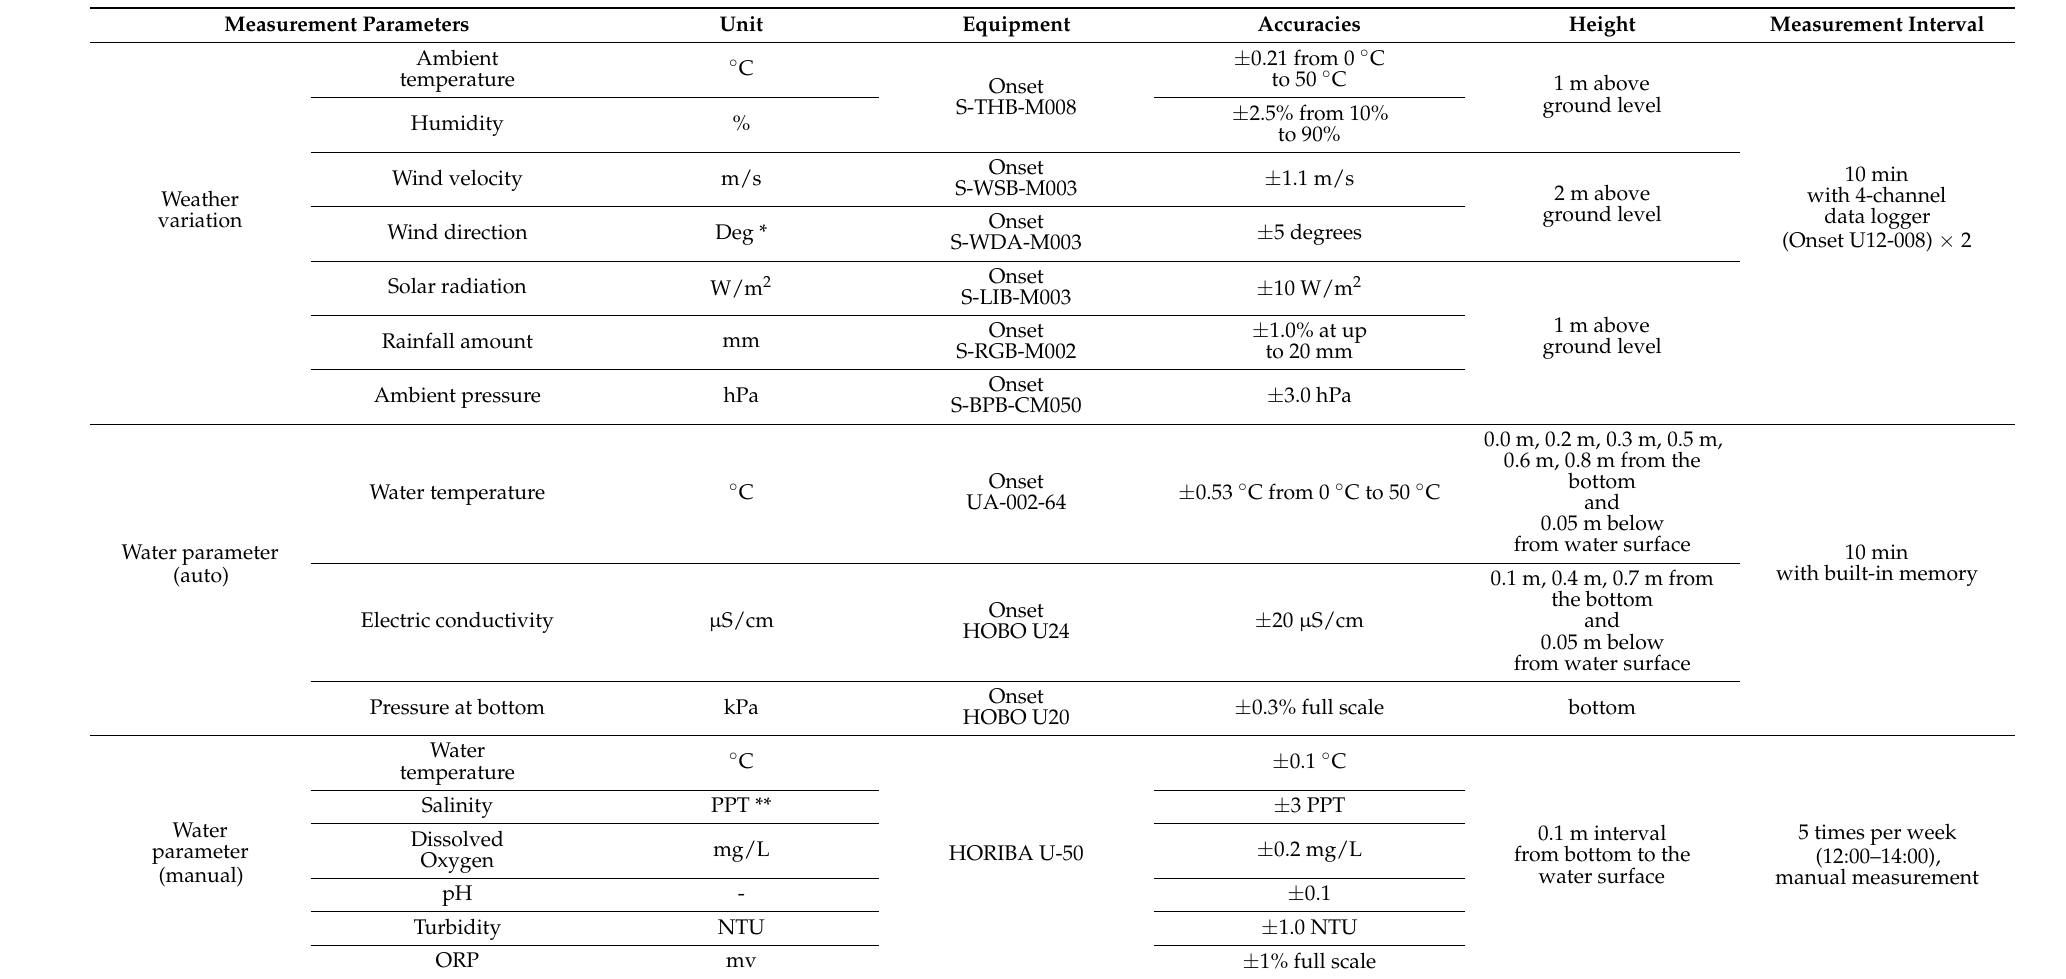
Table 1. Measurement parameters and conditions of weather and water quality